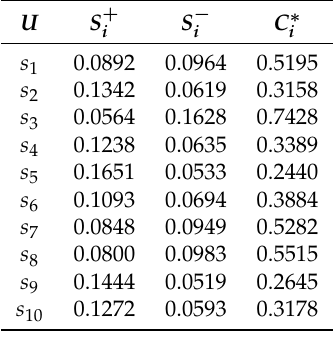
Table 8. Separation measures and the relative closeness